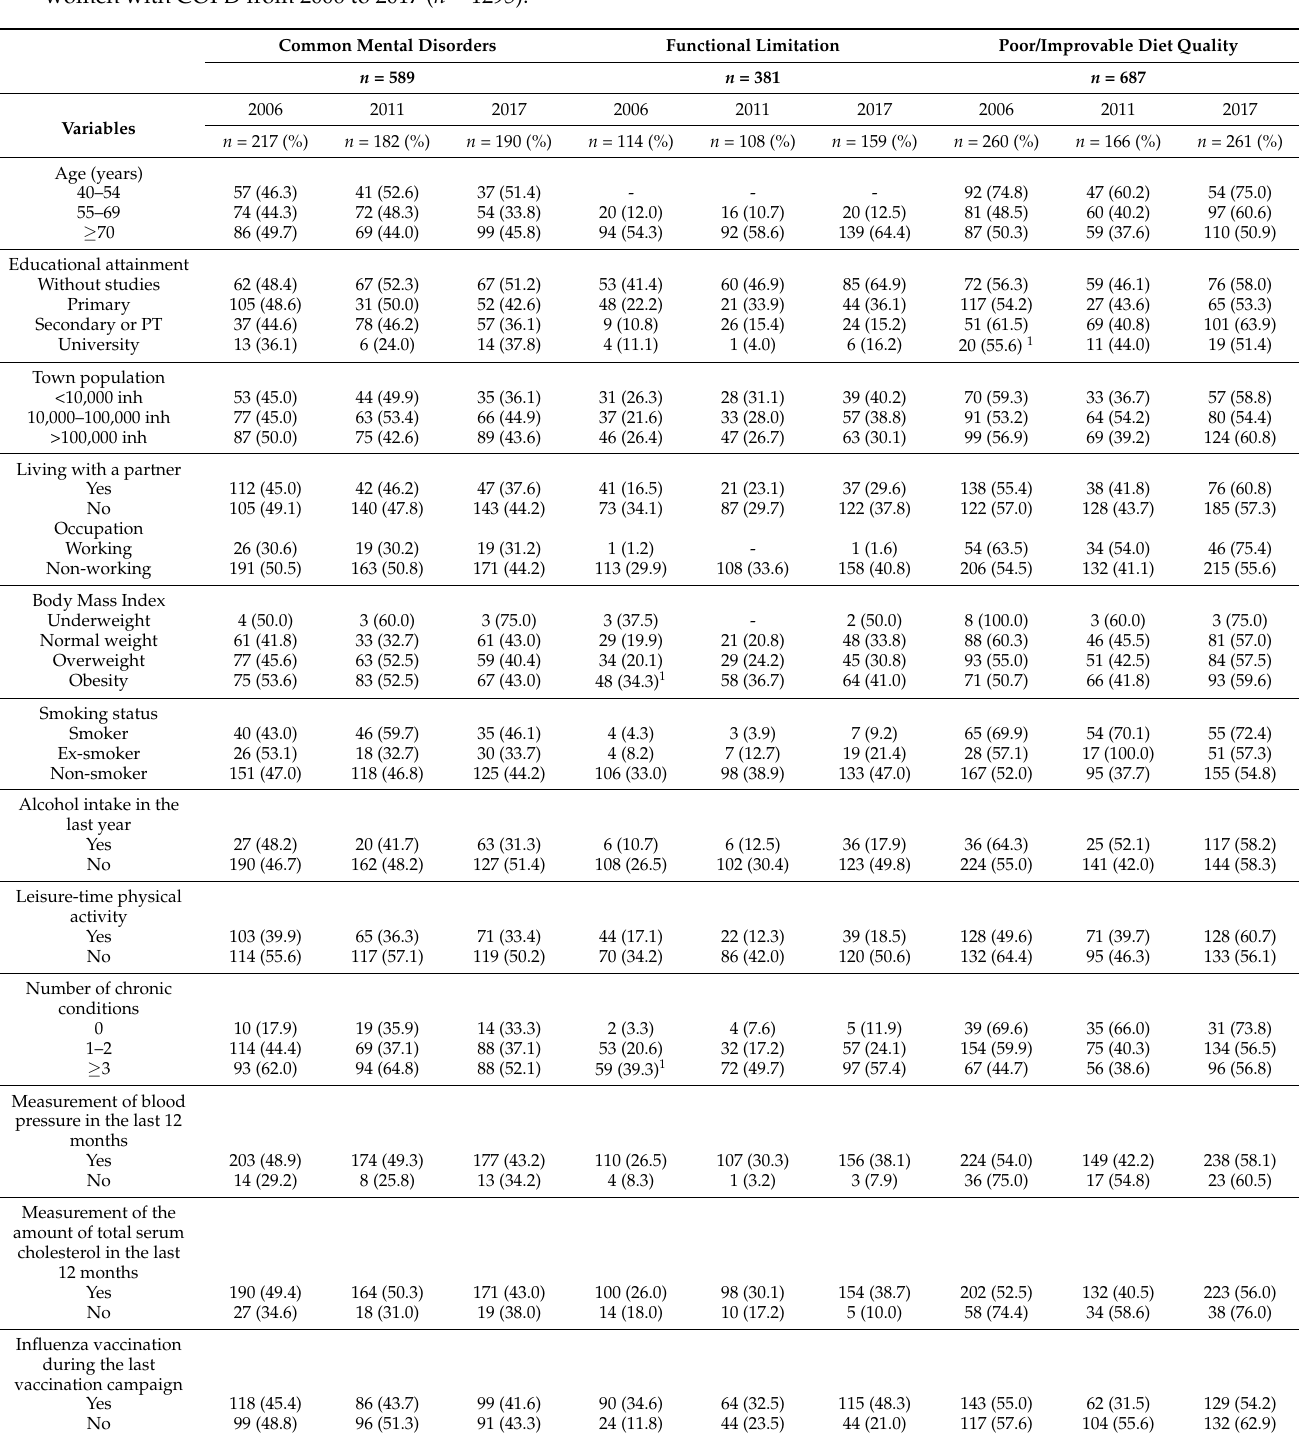
Table 3. Distribution of CMDs, functional limitation and poor/improvable diet quality according to the study variables in women with COPD from 2006 to 2017 ( n =